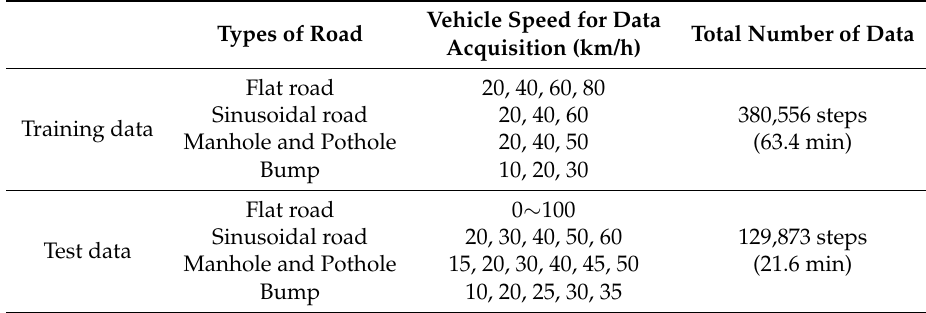
Table 2. Experimental scenario.